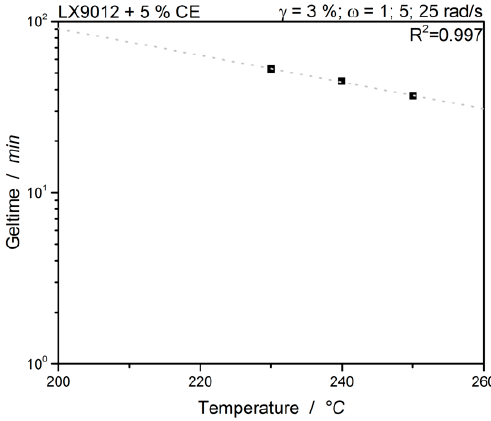
Figure 10. Semi-logarithmic plot of gel-time vs. temperature of LX9012 with 5% CE.